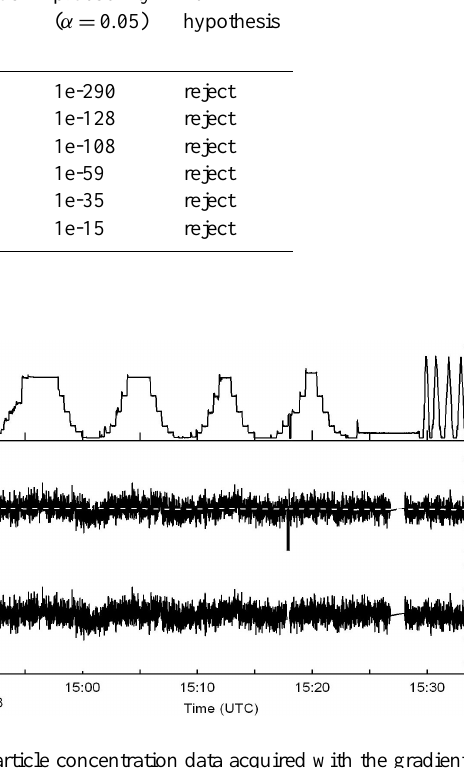
null hypothesis